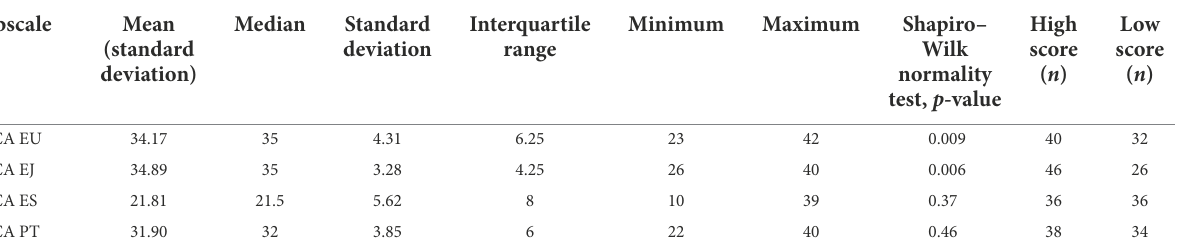
TABLE 4 Scores in each TECA subscale.